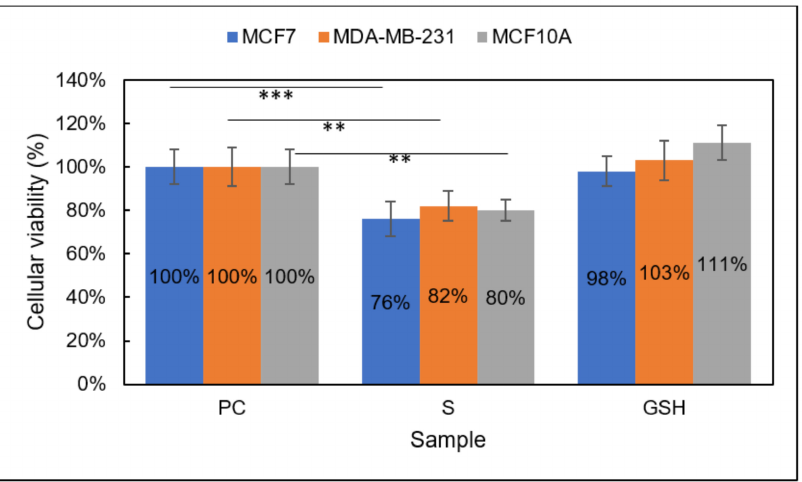
Figure 4. Cellular viability of MCF7 (blue), MDA-MB-231 (orange), and MCF10A (gray) cells analyzed using the CTB assay. Sample groups include: PC (untreated), S (Group 1), and GSH (functional control) cells analyzed using the CTB assay. Data points represent the mean ± standard deviation. Statistical differences from the positive control are indicated by ** p < 0.01, *** p <